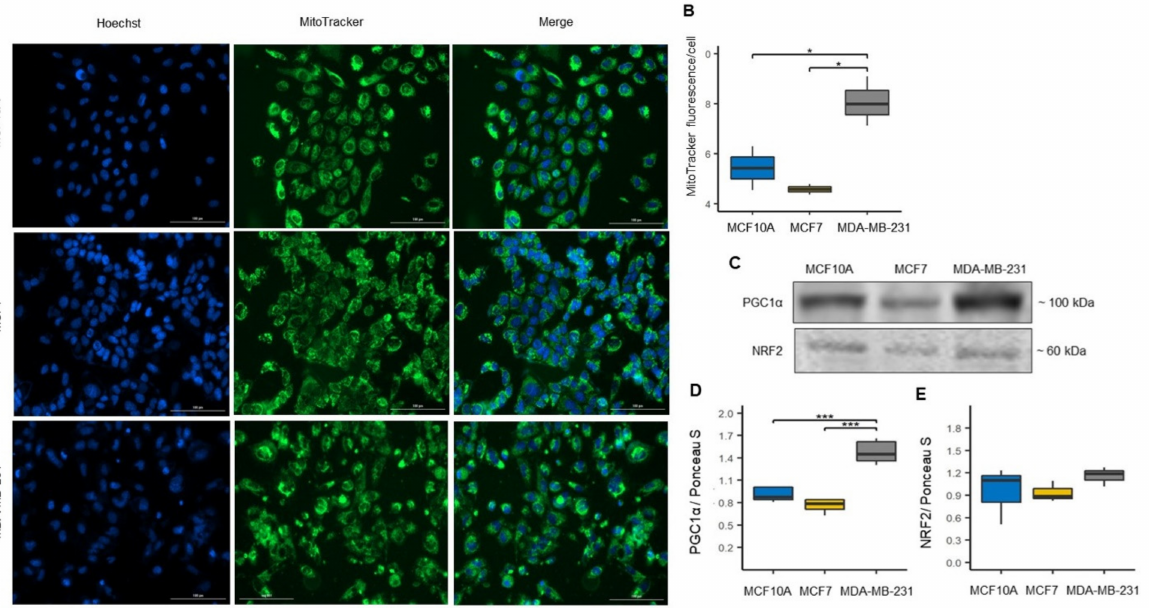
Figure 2. Increased mitochondrial mass in MDA-MB-231 cell line. ( A ) Confocal microscopy images of MitoTracker Green fluorescence to assess mitochondrial mass in MCF10A, MCF7 and MDA-MB- 231 cells, and total nuclei were stained with Hoechst (blue). ( B ) Mitochondrial mass levels were quantified as MitoTracker green fluorescence intensity/cell ratio. Data were obtained from three biological replicates. The data are presented as mean ± SD of cells ( n = 151–251). * p < 0.05. ( C ) Rep- resentative blots. ( D , E ) Expression of mitochondrial biogenesis markers: peroxisome proliferator- activated receptor-gamma coactivator-1alpha (PGC-1 α ), n = 6 and nuclear respiratory factor 2 (NRF2), n = 3. Densitometry values were normalized by Ponceau S red staining. The data are presented as mean ± SD. *** p <